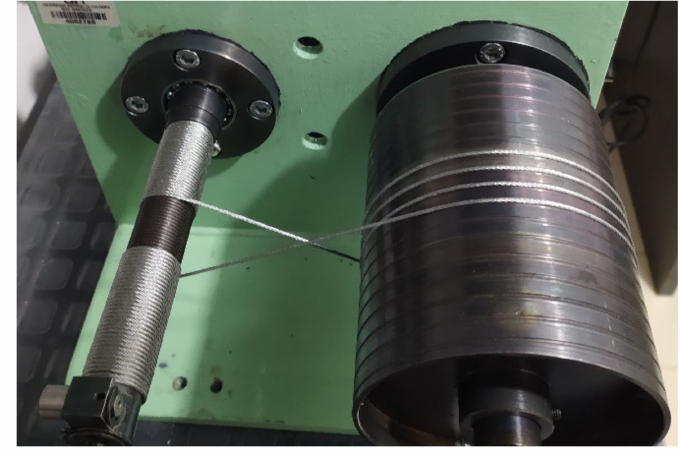
Figure 17. Cable-driven transmission 25–104 X.